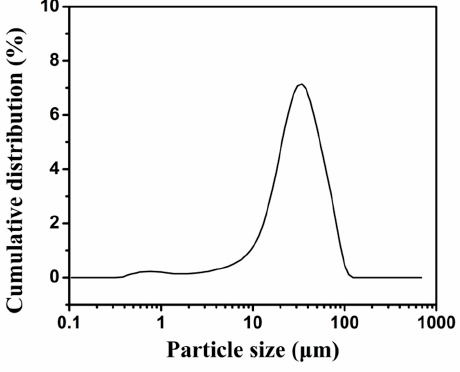
Figure 3. The particle size distributions of MicroPCMs determined using a laser particle size analyzer.